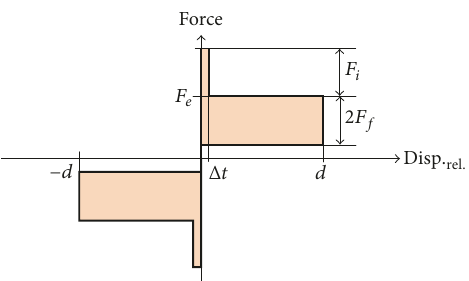
Figure 5: Force-relative displacement relation of the BTI element.